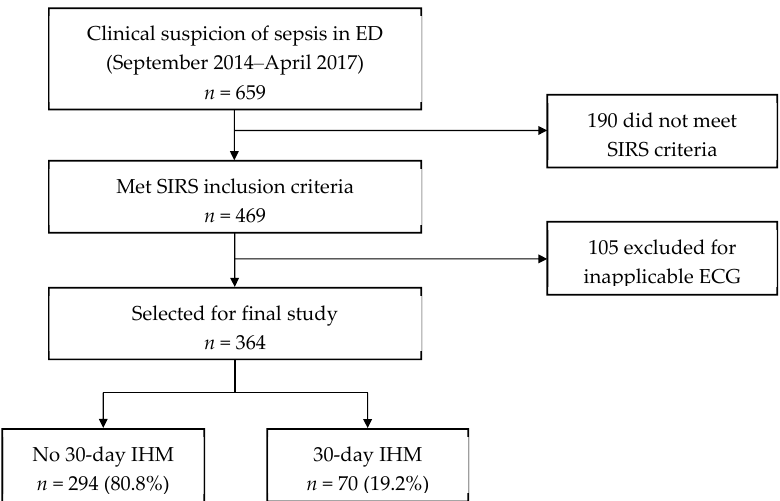
Figure 1. Patient recruitment flowchart. ECG: electrocardiogram; ED: emergency department; IHM: in-hospital mortality; SIRS: systemic inflammatory response syndrome.